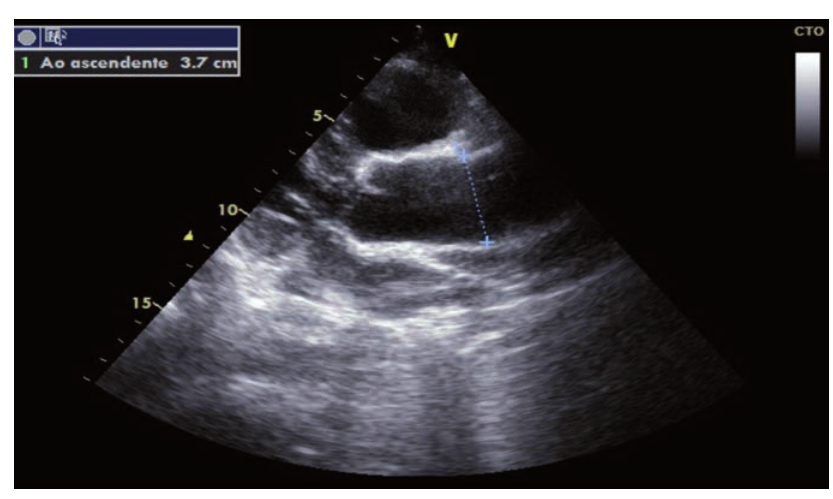
Figure 2. Personal experience (Adult and Pediatric Cardiology Division and Unit of Metabolic Disease St. Gerardo Hospital, Monza, Italy). Fifteen-year old boy (from Kosovo) with type I Gaucher disease and a slight dilatation and calcification of the ascending